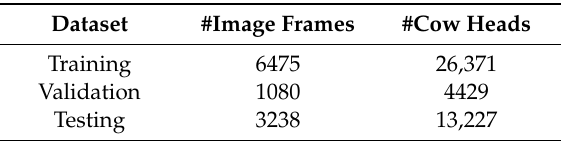
Table 1. The dataset